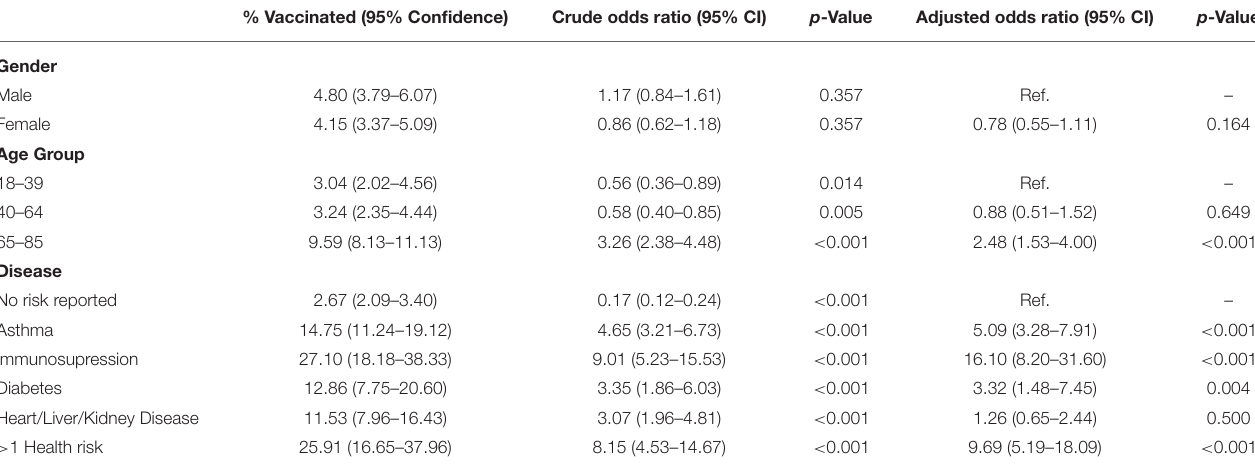
TABLE 2 | Logistic regression of sex, age group, and self-reported health risk factors on adult pneumococcal vaccination